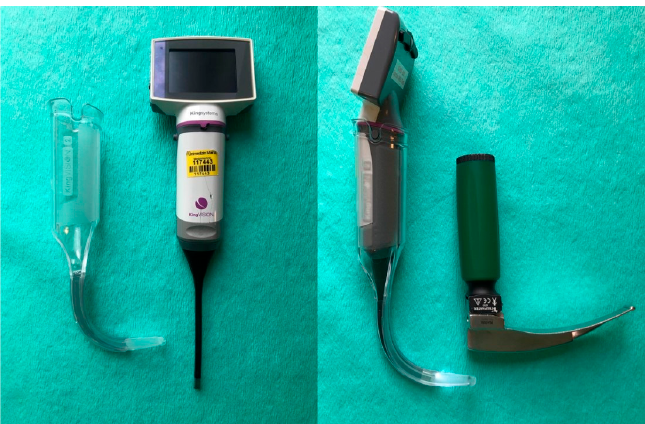
Figure 1. The King Vision™ Paediatric aBlade™ (Ambu ® GmbH, Bad Nauheim, Germany) video laryngoscope (KVL) blade size 2 ( left ) and the Macintosh laryngoscope (DL) blade size 2 ( right ).